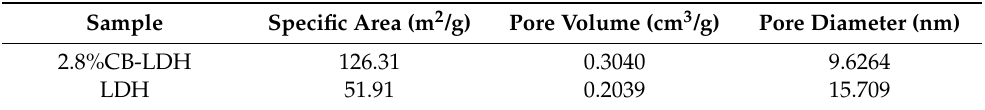
Figure 3. The formation process of hierarchical hydrotalcite ( a ) represents the formation process of surfactant micelles, ( b ) represents the mixing process of mixing metal salt solution and surfactant micelles, ( c ) represents the interaction between hydrotalcite and surfactant micelles, and ( d ) repre- sents the morphology of the multidimensional MgAl-LDH nanoparticles). Table 1. Brunauer–Emmett–Teller (BET) surface area, pore volume and pore diameter of the different MgAl-LDH nanoparticles.